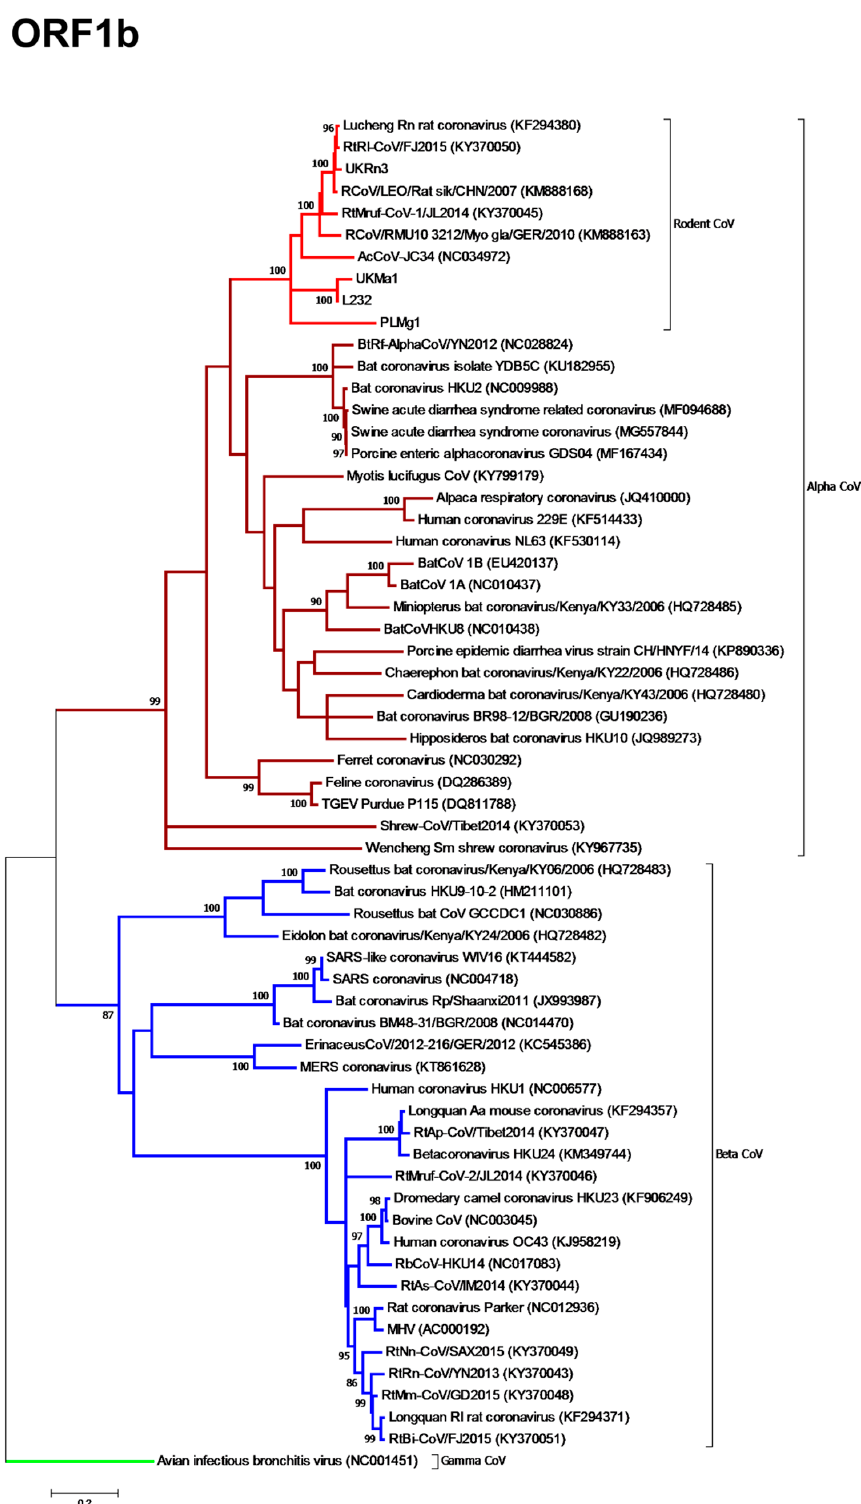
Figure 2. Phylogenetic relationships of the rodent alphacoronaviruses based on the ORF1b gene. Maximum likelihood phylogenetic analysis of coronavirus partial 576 nt ORF1b gene sequences, revealing that the rodent alphaviruses formed a single clade with the novel rabbit L232 CoV within the genus alphacoronavirus. The novel coronavirus sequence obtained from a French rabbit L232 CoV was analysed alongside reference sequences representing three different coronavirus genera ( Alphacoronavirus , Betacoronavirus , and Gammacoronavirus as an outgroup). Reference sequences